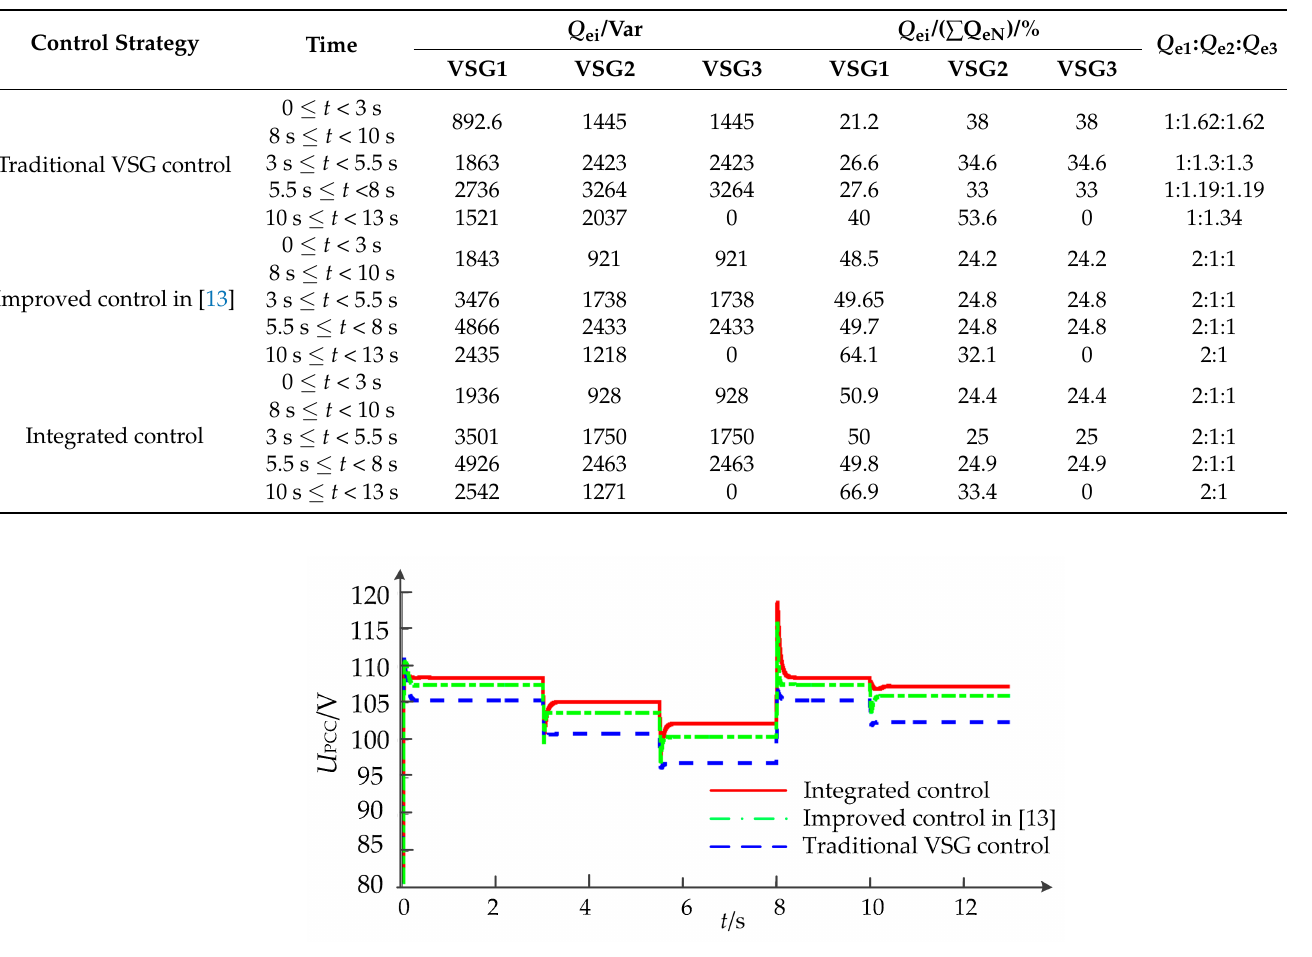
Figure 7. RMS of U PCC with different control strategies. Table 4. Steady-state RMS of U PCC with different control